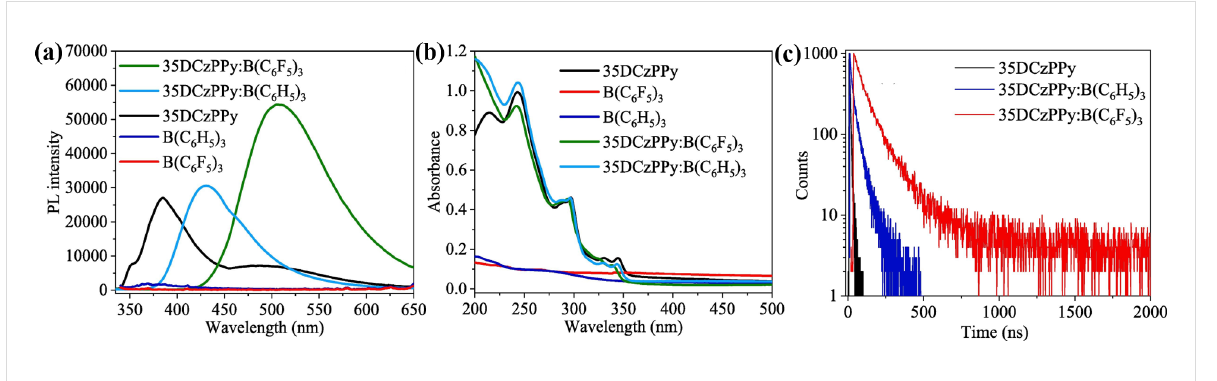
Figure 12: (a) UV–vis absorbance and (b) PL spectra (excited by 330 nm) for 35DCzPPy (compound 14 ), B(C 6 F 5 ) 3 , B(C 6 H 5 ) 3 , 35DCzPPy:B(C 6 F 5 ) 3 (1:1), and 35DCzPPy:B(C 6 H 5 ) 3 (1:1) in films. (c) Fluorescence decay curves for the solid films of 35DCzPPy, 35DCzPPy:B(C 6 H 5 ) 3 , and 35DCzPPy:B(C 6 F 5 ) 3 recorded at photoluminescence maxima (385, 435, and 509 nm) at room temperature. Figure 12 was reprinted from [29], Chemi- cal Engineering Journal, vol. 380, by M. Zhang; G. Xie; Q. Xue; H. Wang, “Electroluminescence of intra-molecular exciplexes based on novel